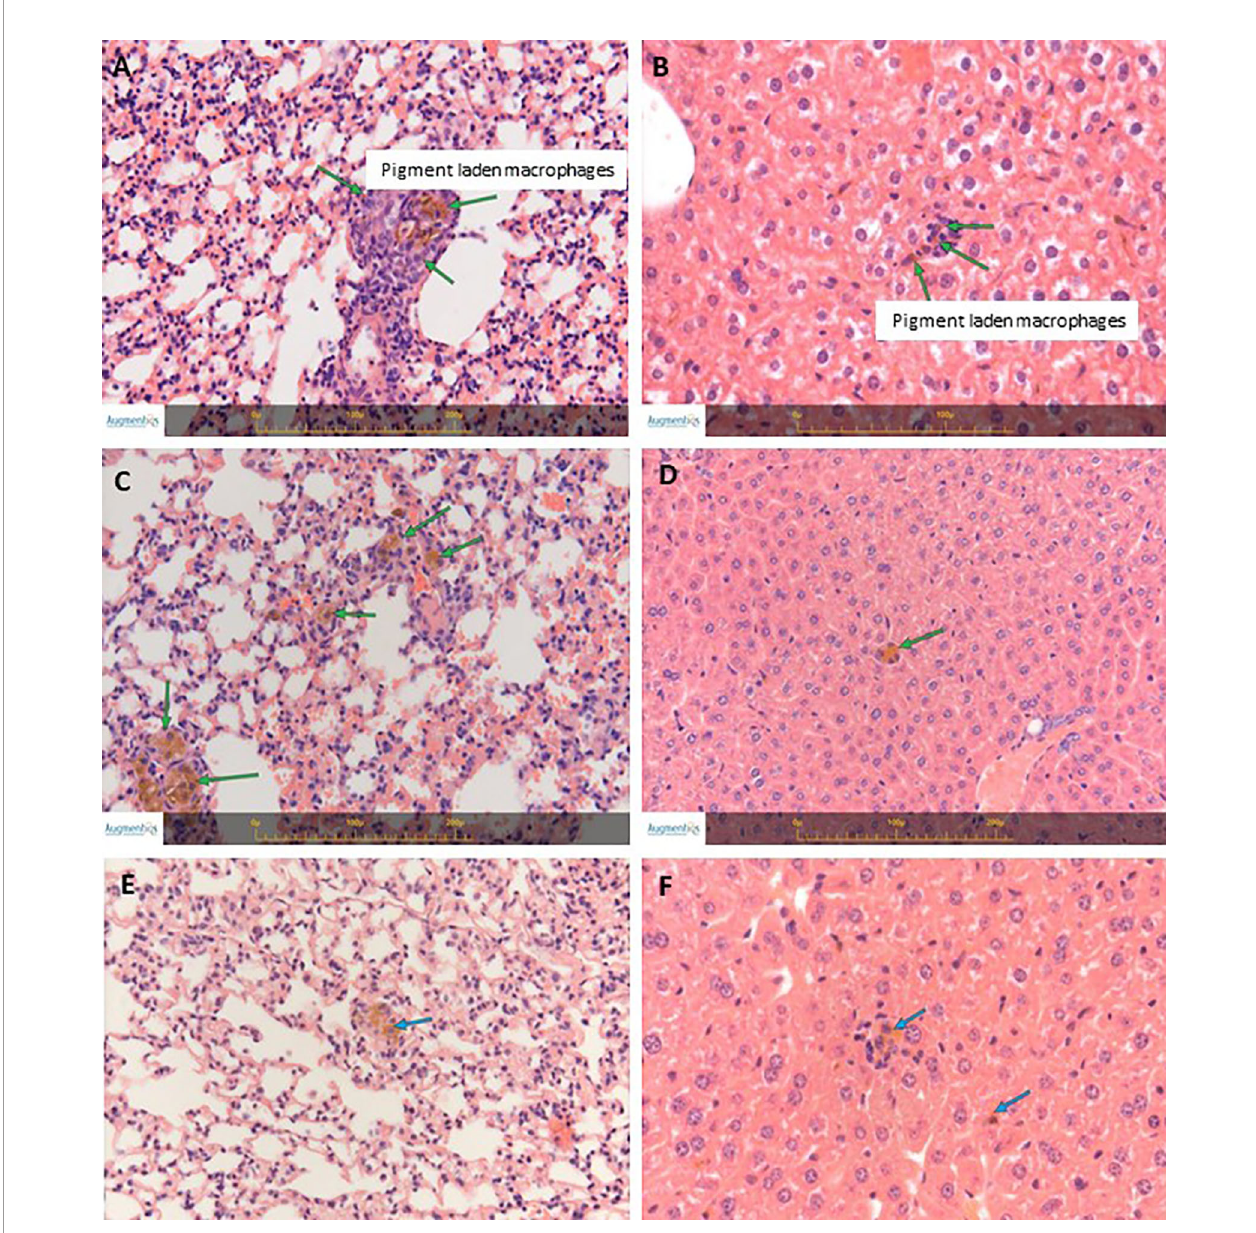
section from a mouse at 30 days post treatment. (F) Liver section from a mouse at 30 days post treatment. Arrows indicate small collections of pigment laden macrophages in the liver (Kupffer cells) and in the lungs, associated with minimal mononuclear cell in fi ltration. Images were captured using the Augmentiqs system software (14). Results are representative of 3 different